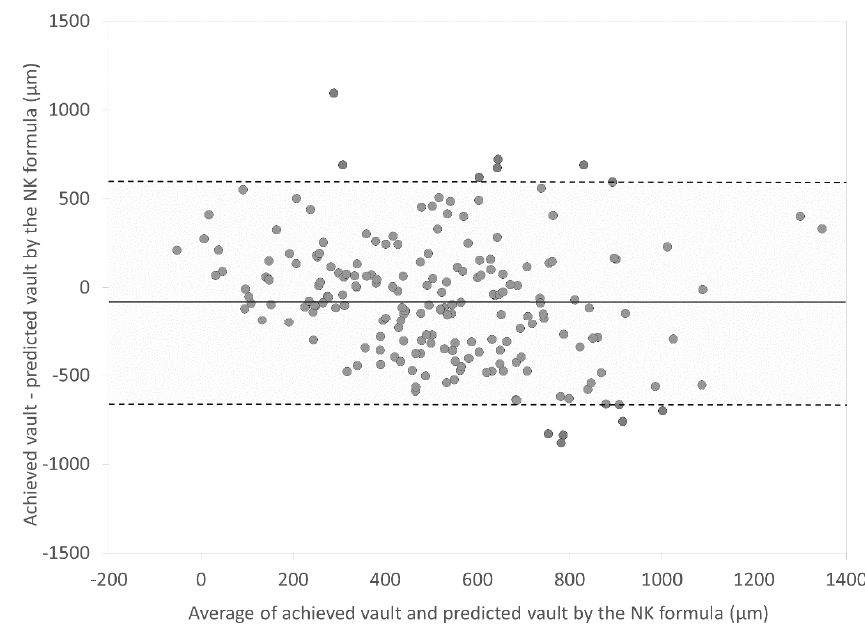
Figure 1. Bland–Altman plots showing the difference between the achieved vault and the predicted vault by the NK formula divided by the mean of the achieved vault and the predicted vault. The solid line represents the mean difference between two consecutive measurements of corneal astigmatism, dotted lines are the upper and lower borders of the 95% LoA (mean difference ± 1.96 multiplied by standard deviation of the mean difference).